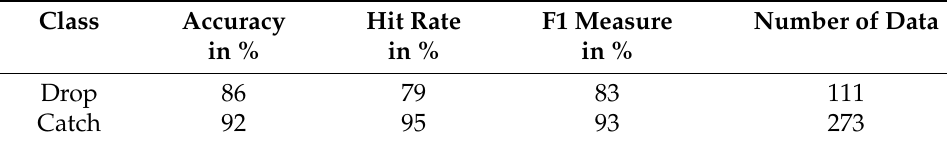
Table 7. Model evaluation with the test dataset in video classification.